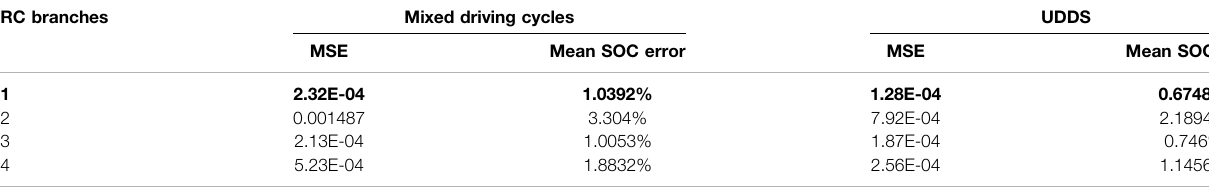
TABLE 21 | Augmented ECM-based H-in fi nity with 20% bias.